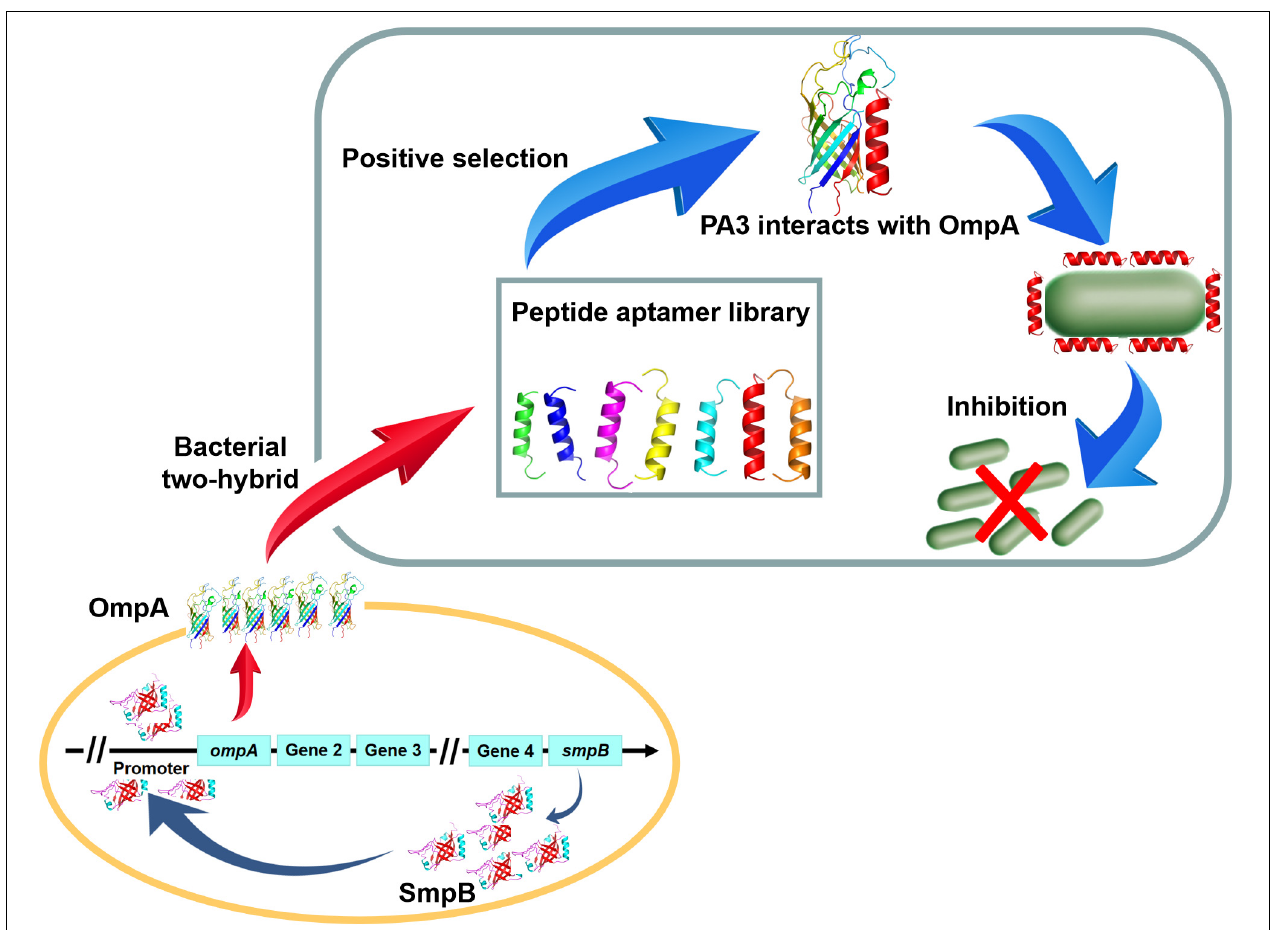
FIGURE 6 | The schematic diagram of Peptide aptamer PA3 attenuates the viability of A. veronii by hindering of SmpB-OmpA signal pathway.